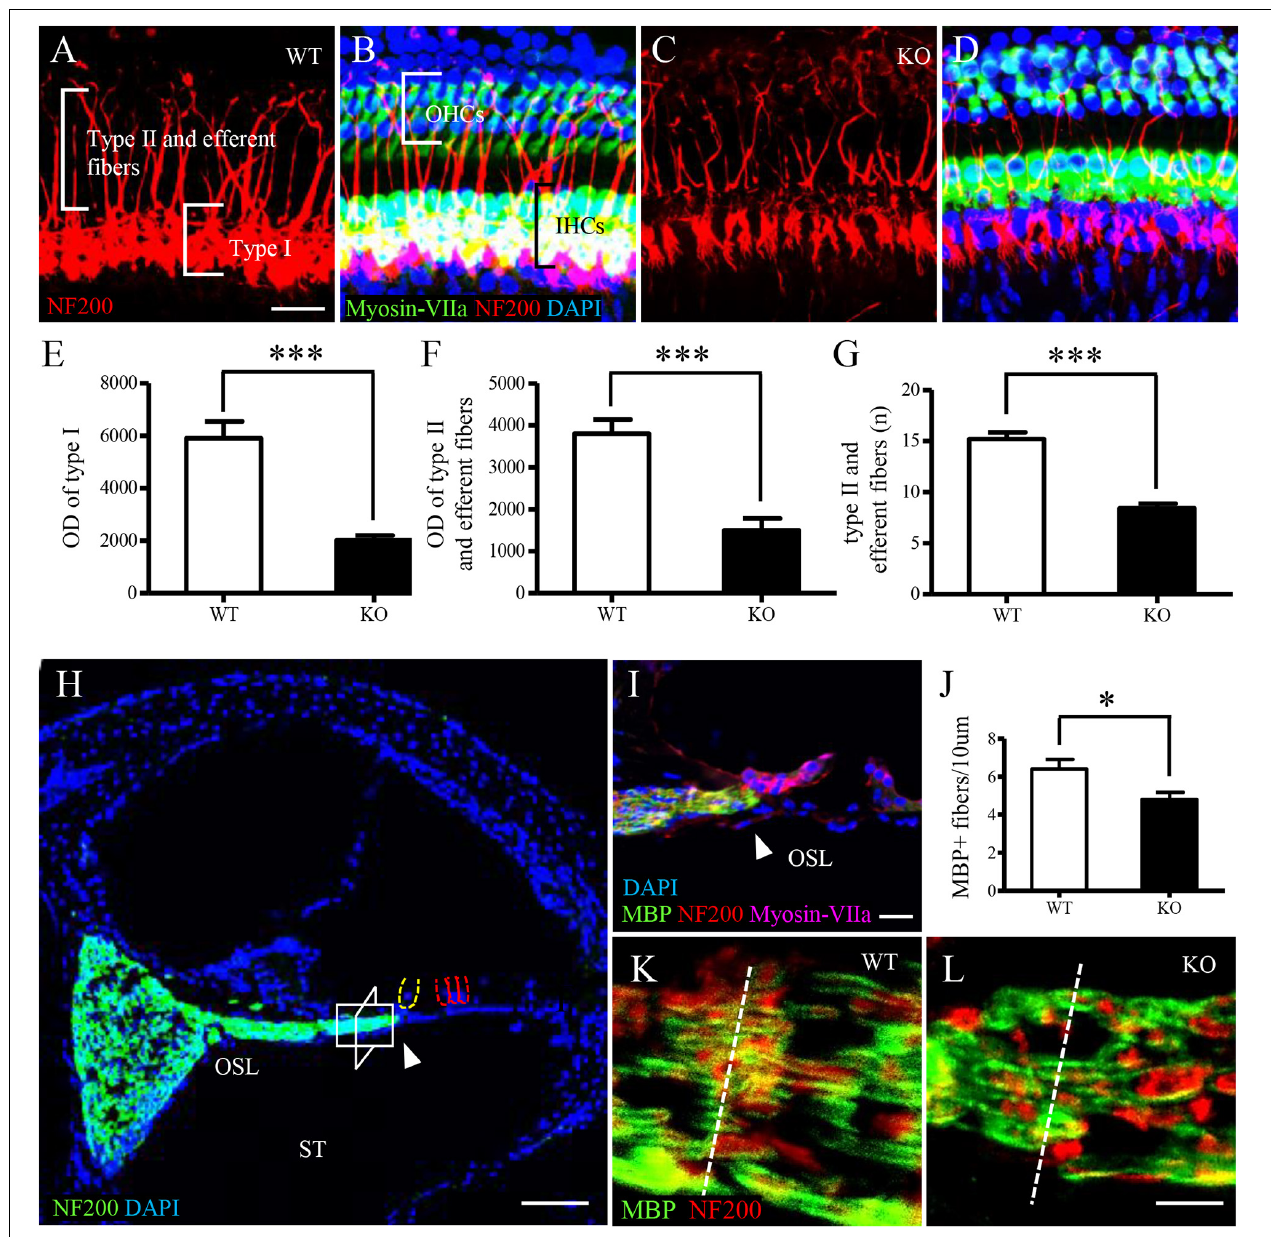
FIGURE 4 | Auditory nerve fibers in C1ql1 WT and C1ql1 KO mice. (A,C) Type I, type II auditory nerve fibers and efferent fibers (red, labeled by anti-NF200) in C1ql1 WT mice (A) and in C1ql1 KO mice (C). Scale bar = 10 µ m. (B,D) Morphology of cochlea under basilar membrane stretched preparation technique. (B) Cochlear basilar membrane in C1ql1 WT mice. (D) Cochlear basilar membrane in C1ql1 WT mice. Cytoplasm of hair cells was marked with anti-myosin VIIa antibody (green), nucleus of cells with DAPI (blue), and auditory nerve fibers and efferent fibers with anti-NF200 (red). Scale bar = 10 µ m. (E) is the statistical difference in optical density (OD) value of Type I auditory nerve fibers and (F) is the statistical difference in OD value of Type II auditory nerve fibers and efferent fibers between C1ql1 KO mice and C1ql1 WT mice. (G) Is the statistical difference in number of Type II auditory nerve fibers and efferent fibers between C1ql1 KO mice and C1ql1 WT mice. (H) Morphology of cochlea under cochlear horizontal sections. Scale bar = 25 µ m. (I) Amplification of osseous spiral lamina (OSL) regions in cochlea. Scale bar = 10 µ m. The arrow points to habenular opening in (H,I) . (J) Statistical difference in number of Type I auditory nerve fibers between C1ql1 KO mice and C1ql1 WT mice. Measurements were made in the area about 20–30 mm from the habenular opening. The measured areas in C1ql1 WT mice and C1ql1 KO mice were showed in (K,L) , respectively. Scale bar = 5 µ m. ∗ P < 0.001 and ∗∗∗ P <